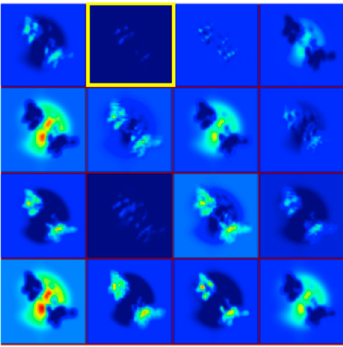
Figure 1. Illustration of feature maps learned by convolutional neural network (CNN) in a synthetic aperture radar automatic target recognition (SAR ATR) experiment.